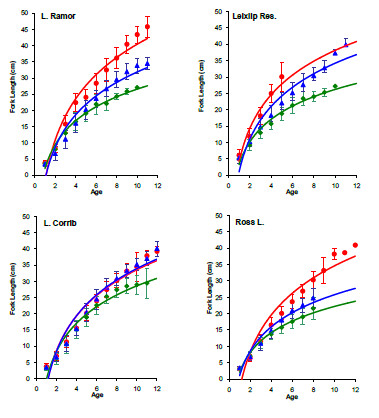
Location of study sites. Outline map of Ireland displaying the location of the four lakes sampled for the study. Location of Ireland relative to Northern Europe displayed in inset.